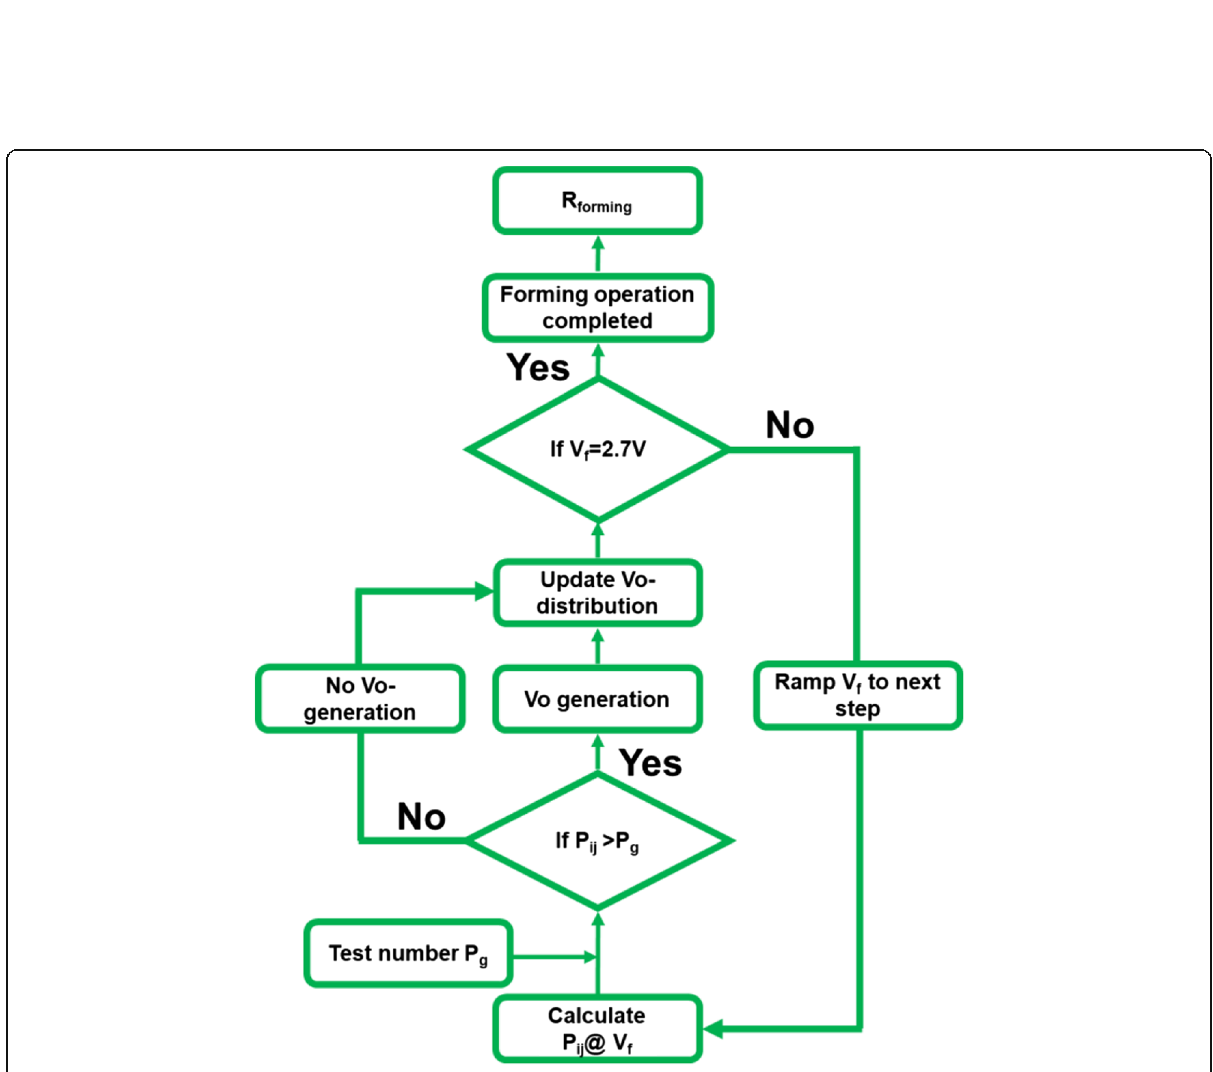
Fig. 7 Simulation flow of a forming process based on the thermal chemical model, by assuming the dielectric failure time with electric field dependency of exp.( −